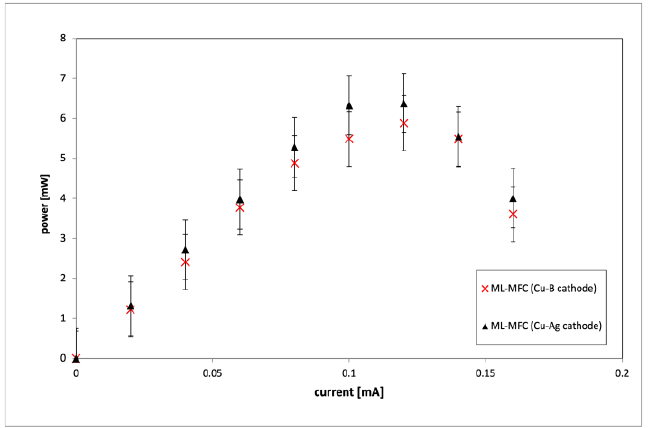
Figure 10. Power curves obtained during the ML-MFC operation. Cathode: Cu-Ag (5% of AG, after 6 h of oxidizing and after 3 times of anodic charge); and Cu-B (9% of B, after 8 h of oxidizing and after 3 times of anodic charge) for comparison [26,63].